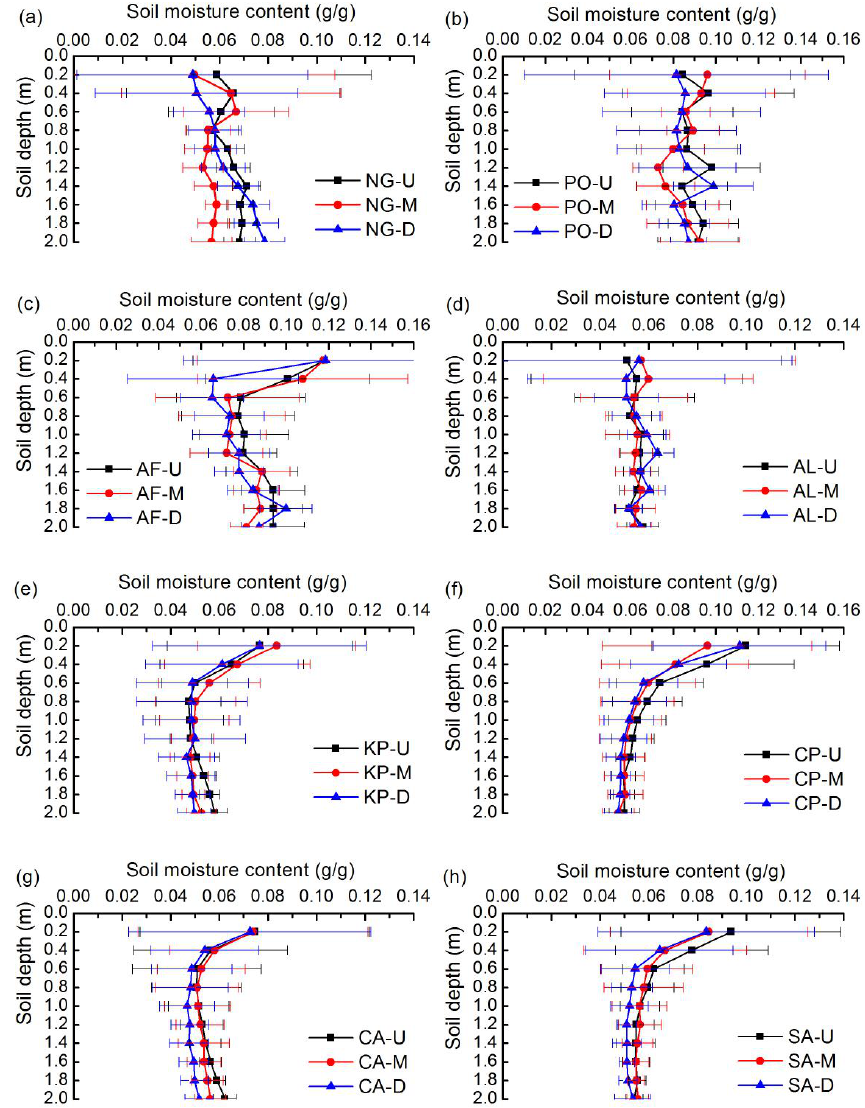
Fig. 2. Comparison of temporal-averaged shallow soil moisture content (SMC) on different slope positions. Note: NG represents native grassland; PO represents farmland planted with potato; AF represents abandoned farmland; AL represents alfalfa; KP represents korshinsk peashrub; CP represents Chinese red pine; CA represents Chinese arborvitae; SA represents Siberian apricot. The number of samples of shallow soil moisture content was 26. The last letter U refers to upper position, M to middle position, and D to downhill position. For example, NG-U, NG-M and NG-D refer to upper position of natural grassland, middle position of natural grassland and downhill position of natural grassland,